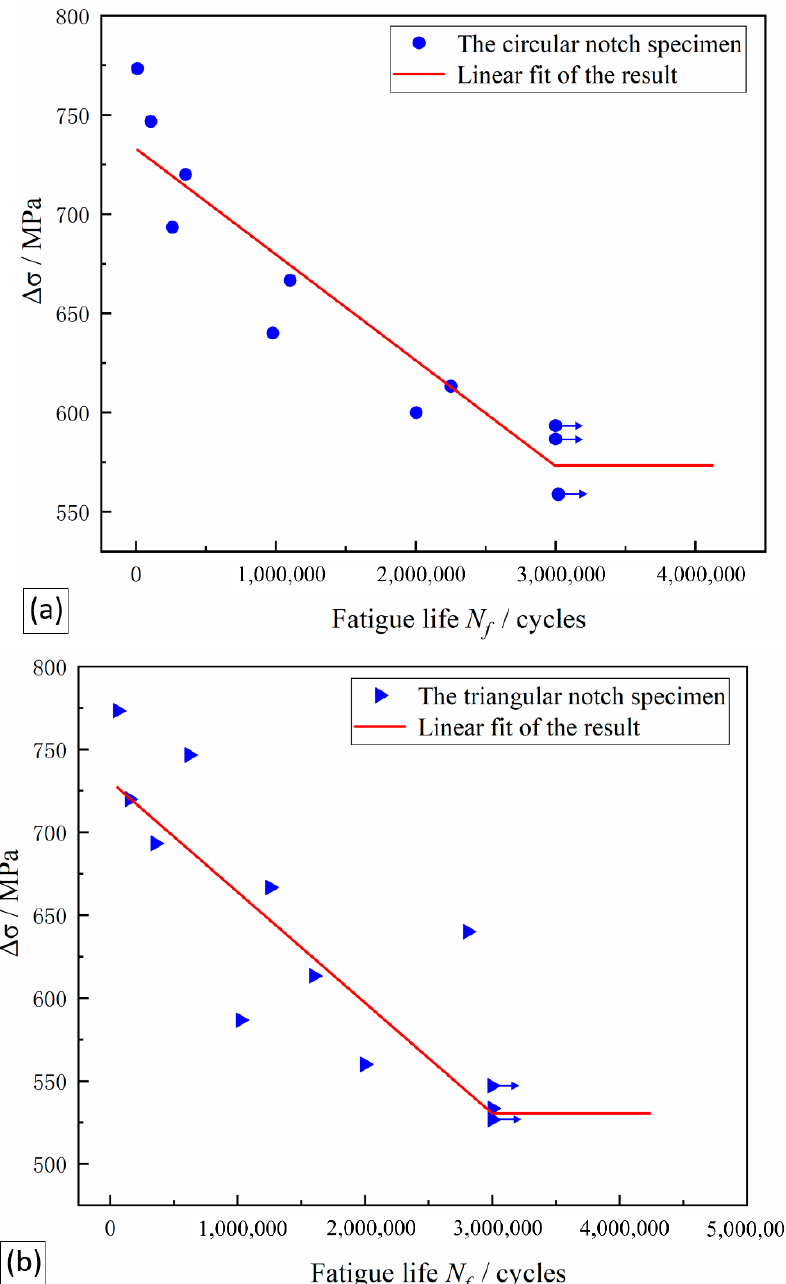
Figure 9. S-N curves of the notched specimens: ( a ) circular notched specimens and ( b ) triangular notched specimens.